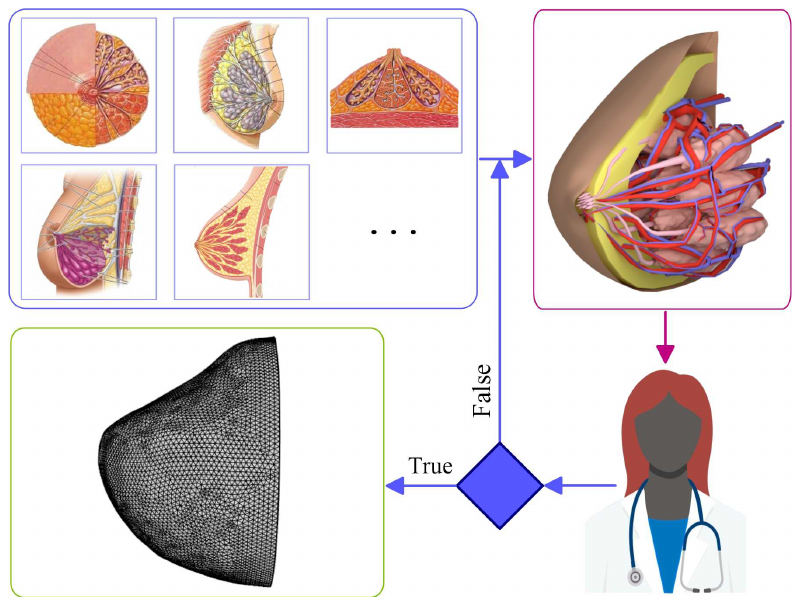
Figure 6. General procedure for constructing a 3D model of biological